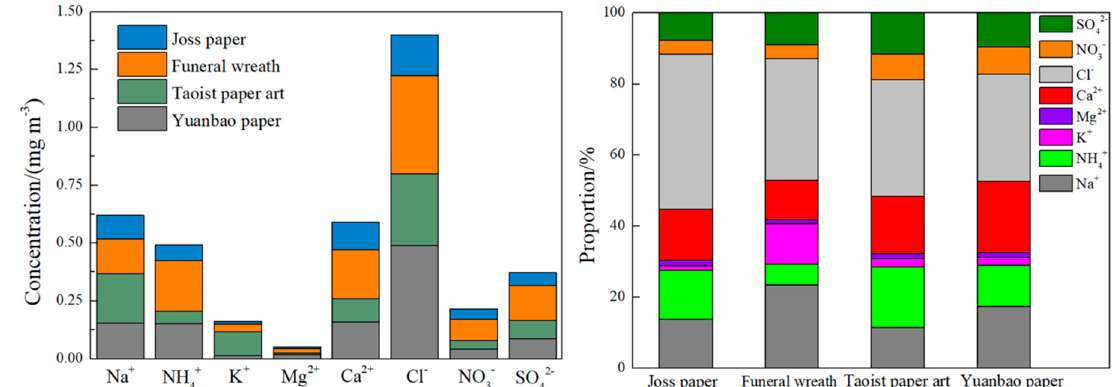
Figure 9. Concentrations and percentages of water-soluble ions in PM 2.5 generated from the incineration of sacrificial offerings.